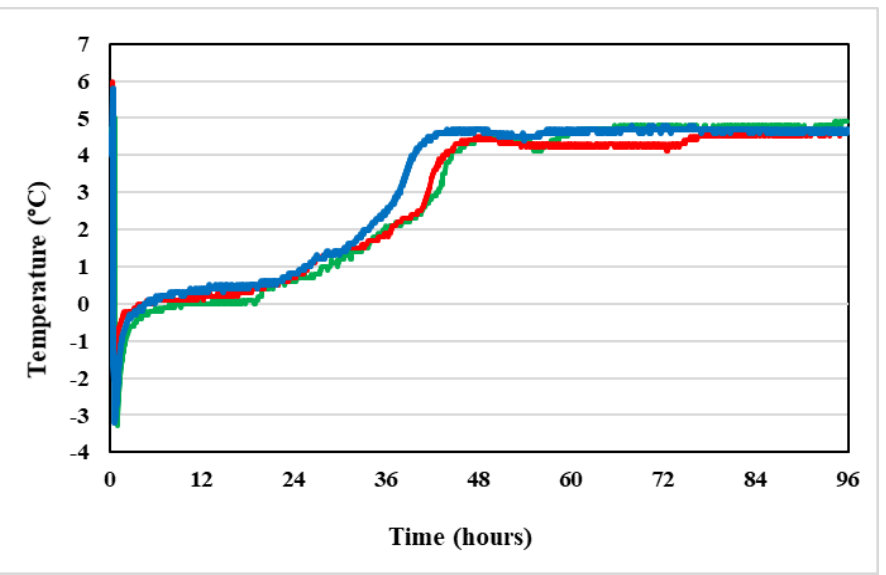
Figure 11. Trend of the temperature of the three Vidaza ® samples (red, green, and blue lines, respectively) stored refrigerated (2 – 8 °C) between two refrigerant gel packs, obtained placing a temperature data logger into the polypropylene syringes in contact with the drug suspension.